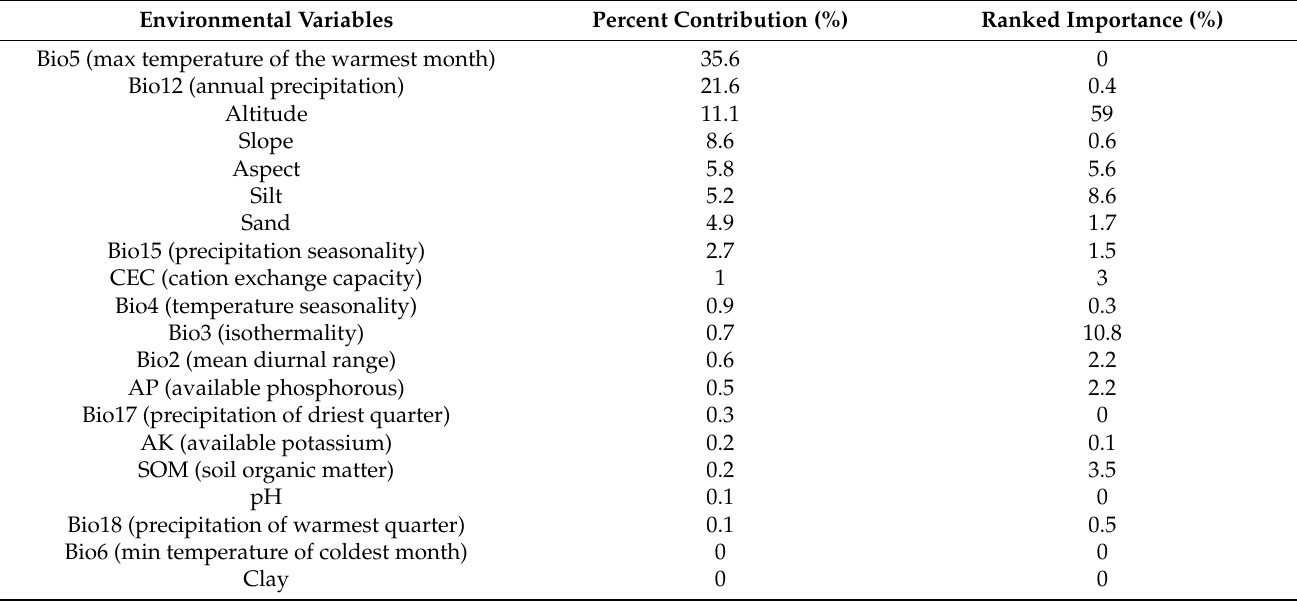
Table 2. Percentage contribution and ranked importance of environmental variables in the Maxent model .